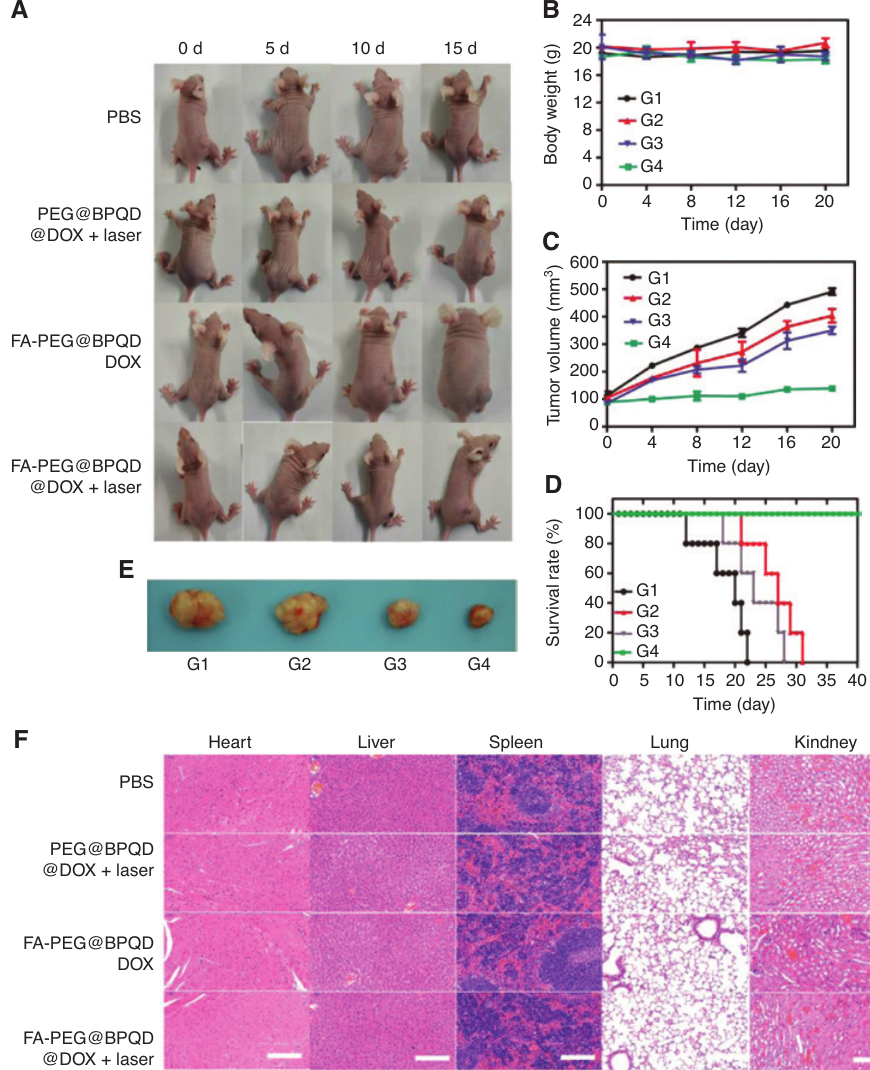
Figure 7: In vivo therapeutic effects of FA-PEG@BPQD@DOX. (A) The images of mice injected with different agents. (B) The changes in body weight and (C) tumor volume of the mice. (D) The survival analysis of mice. (E) The resected tumors after PDT treatment for 20 days. (F) The H&E staining